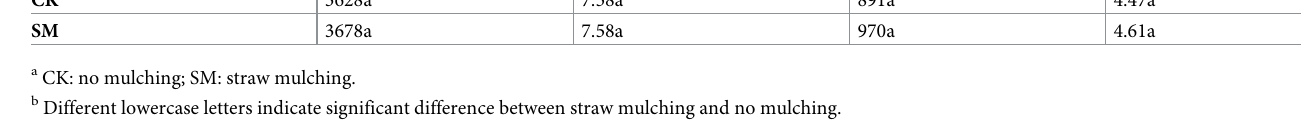
The microbial relative abundance of phyla and class varied with different incubation tem- peratures (Fig 6 and S2 and S3 Tables). The relative abundances of phyla Chloroflexi , Acidobac- teria , and Bacteroidetes decreased with incubation temperature, while the relative abundance of the phylum Gemmatimonadetes was greater at 35 ˚C than at 15 ˚C and 25 ˚C. For bacteria, the relative abundance class of Alphaproteobacteria , a branch of Proteobacteria , was greater at 15 ˚C than at 25 ˚C and 35 ˚C under CK, but was greater at 15 ˚C and 25 ˚C than at 35 ˚C for SM. The relative abundance class Betaproteobacteria was greater at 35 ˚C than at 15 ˚C and 25 ˚C under SM, and had no difference for CK. For Actinobacteria , the relative abundance of Acidimicrobiia decreased with increasing incubation temperatures under SM. The relative abundance of phyla Chloroflexi in CK and Acidobacteria in SM were greater at 15 ˚C and 25 ˚C than at 35 ˚C. The dominant fungal phyla consisted of Ascomycota (73.8%), Basidiomycota (9.71%), and Zygomycota (5.49%) (Fig 6). For fungi, when averaged across incubation temperature, the rela- tive abundance of phylum Ascomycota was lower, and Basidiomycota was greater in SM than CK (Fig 6, S4 and S5 Tables). For the phylum Ascomycota , the class Sordariomycetes was the most dominant class and was similar in CK and SM. The relative abundance of the phylum Basidiomycota was greater in SM than CK at 15 ˚C and 25 ˚C. The relative abundance of the fungi Ascomycota increased with increasing incubation temperatures. No significant difference in other dominant fungal phyla was found among the different incubation temperatures.